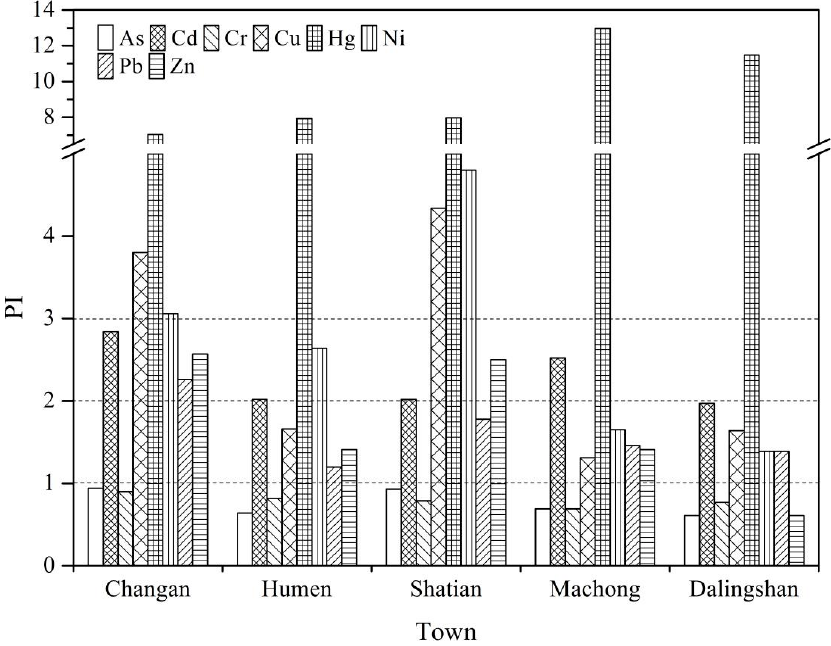
Figure 4. The mean pollution index ( PI ) of heavy metals in topsoils in different towns of Dongguan. In the towns of Humen and Machong, the PI values of Cd, Cu, Ni, Pb, and Zn were between 1 and 3, which indicated low to moderate pollution. Dalingshan was predominantly polluted with Cd,